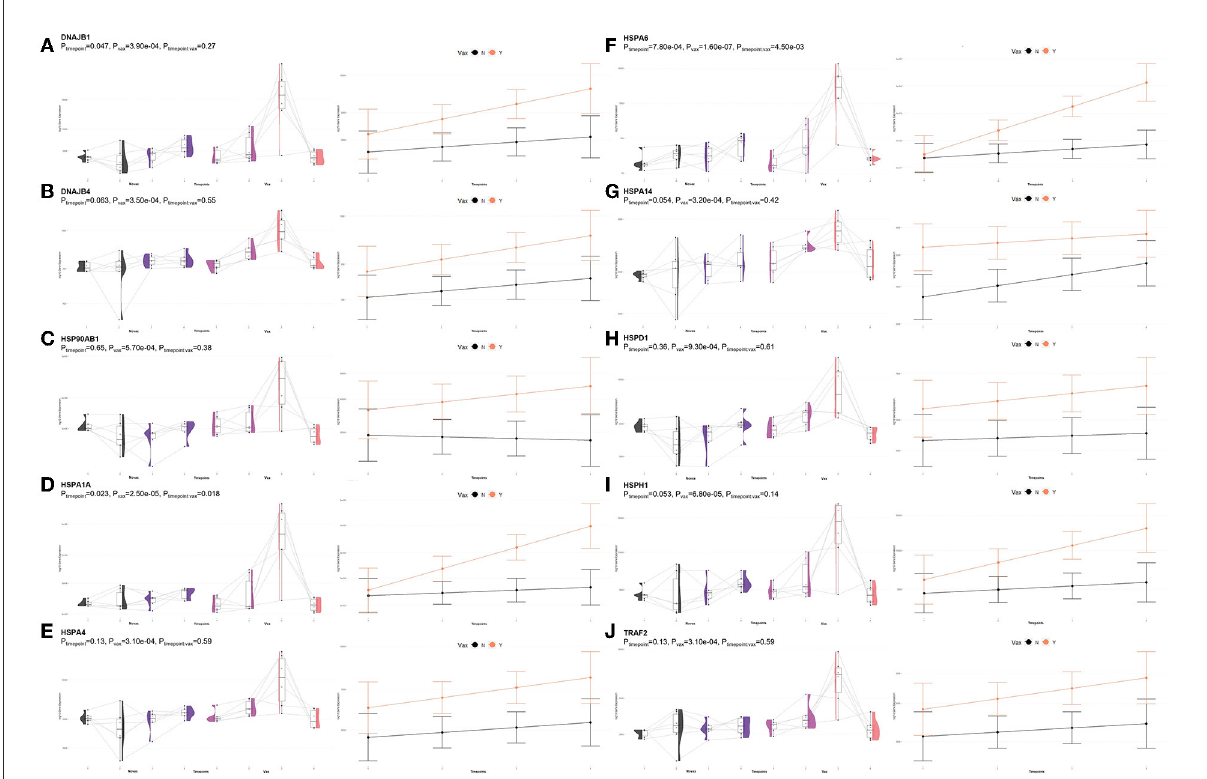
FIGURE9 Gene pairplots and modeled expression trends of key DEGs found in timepoint analyses. Pairplots (left side) demonstrate the log10 normalized gene expression of each sample across all timepoints, overlapped with a violin plot (depicting numerical distributions by density). Box-and-whisker plots represent median expression values (black line), the first (lower) and third quartiles (boxplot limits), 1.5 times the interquartile ranges (whiskers), and outlier expression levels for each timepoint (points outside whiskers). Modeled expression trends (right side) depict the overall differences between groups over each timepoint. Points represent the mean log10 normalized expression value for each group within a timepoint, and bars represent the standard error of log10 normalized expression for each group; orange represents the vaccinated group and black represents the non-vaccinated group. These plots depict the relative expression and glmmSeq level of significance for (A) DNAJB1 , (B) DNAJB4 , (C) HSP90AB1 , (D) HSPA1A , (E) HSPA4 , (F) HSPA6 , (G) HSPA14 , (H) HSPD1 , (I) HSPH1 , and (J) TRAF2